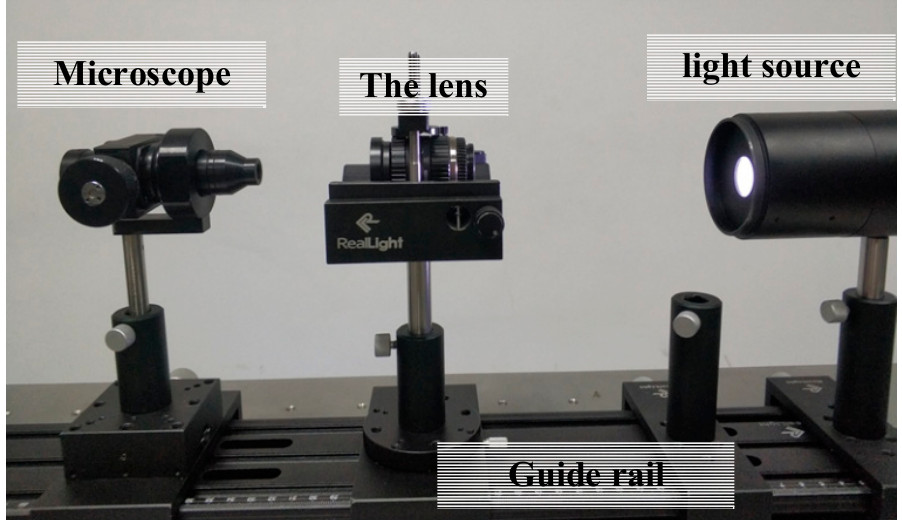
Figure A1. Experimental setup for measuring the distance d p